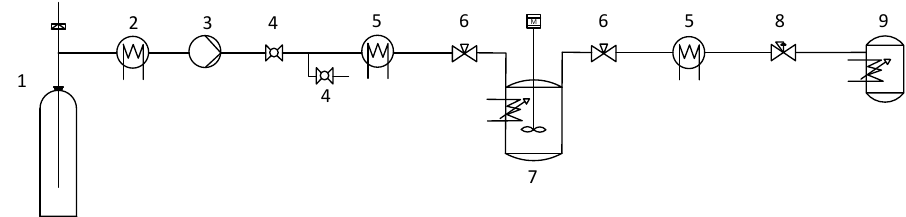
Figure 8. Schematic diagram of the equipment used for the scCO 2 sterilization treatment. Legend: 1. CO 2 bottle; 2. chiller; 3. CO 2 injection pump; 4. ball valves; 5. heat exchangers; 6. heated needle valves; 7. pressure vessel equipped with a stirrer, a refrigeration coil system and a heating jacket; 8. Backpressure regulator; and 9. collector vessel.